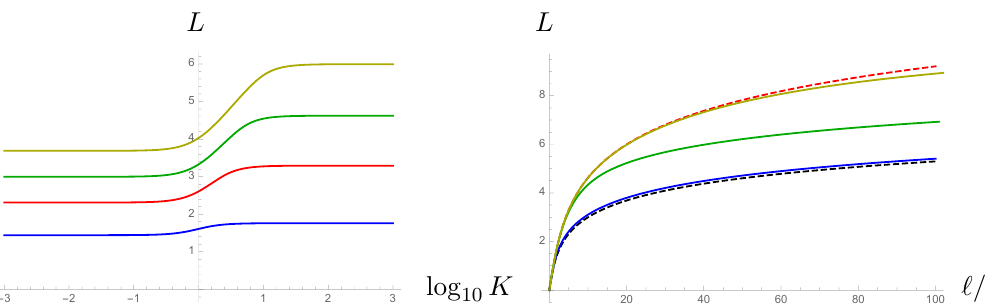
Figure 4 . Entanglement entropy for a (cid:13)ow between a CFT in the IR and z = 2 Lifshitz theory in the UV. Left: length as a function of log K for ‘=" = 2 ; 5 ; 10 ; 20 (bottom to top). These curves 10 interpolate monotonically between the correct IR (left) and UV (right) limits. Right: length as a function of ‘=" for K = 0 : 5 ; 5 ; 50 (bottom to top, solid). The dashed lines correspond to the IR (black) and UV (red)